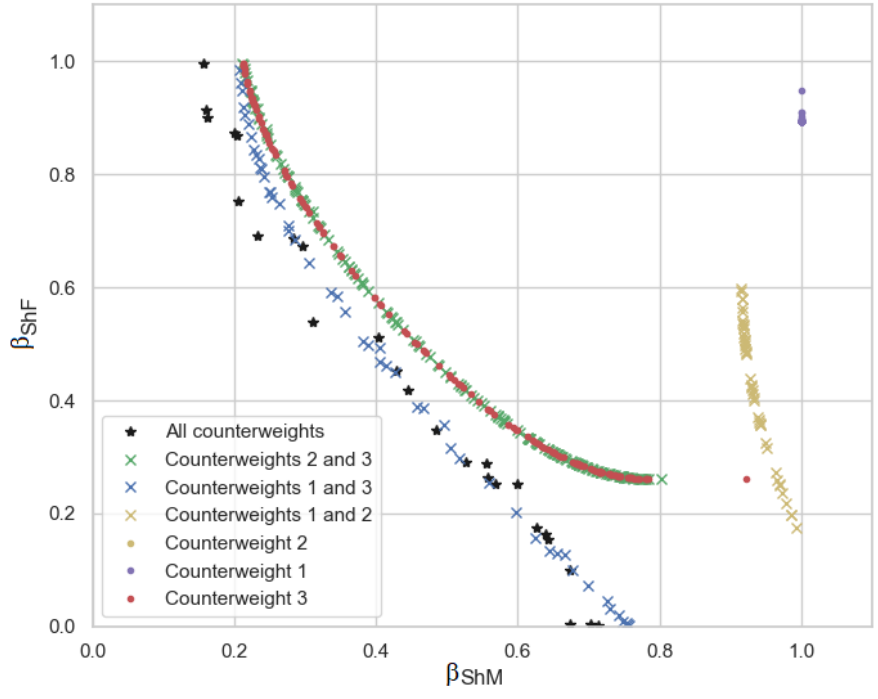
Figure 8. Pareto front